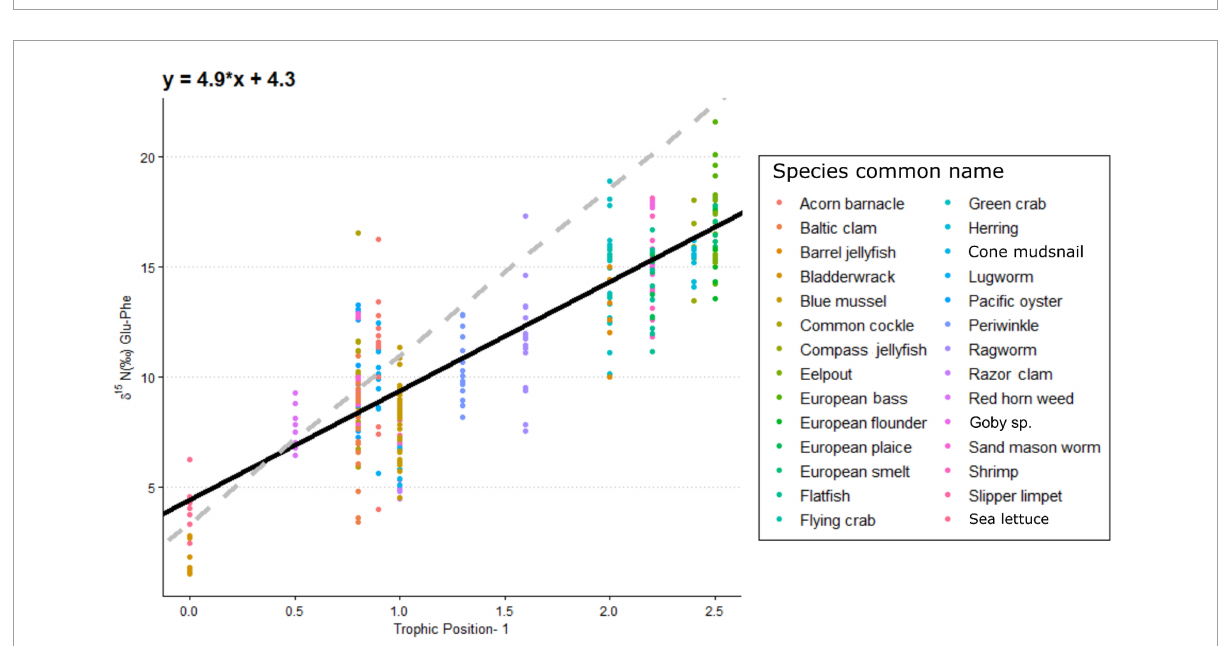
FIGURE3 The per mil difference in δ 15 N value between glutamic acid and phenylalanine in relation to trophic levels for individual species minus one level to account for primary producers. The black line is the fitted linear regression across all species (r 2 = 0.7, n = 337) with the equation presented at the top left of figure. The dashed gray line is the linear trophic level relationship using a slope of 7.6% and a β of 3.4% as presented in Chikaraishi et al. (2009).